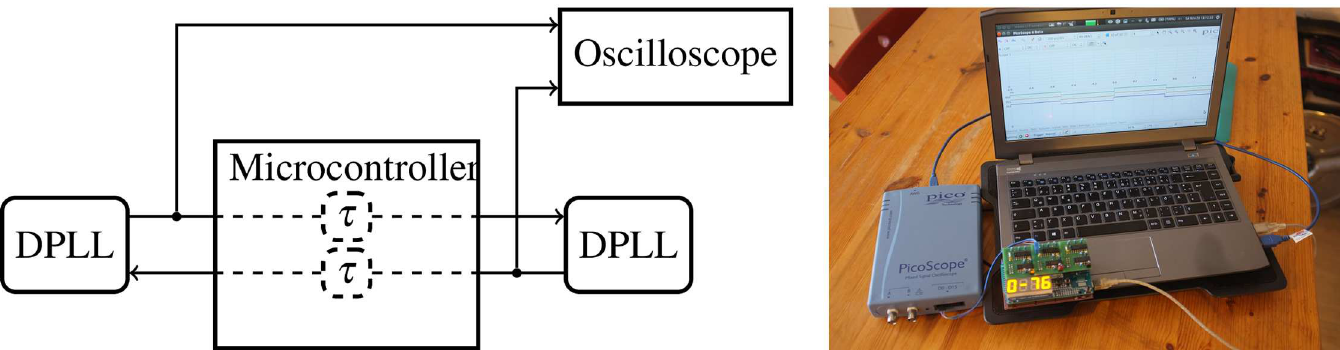
Fig 9. Experimental setup, sketch and photograph. Two DPLLs coupledthrough a microcontroller, which artificiallyintroducesa transmission delay. An oscilloscopesamplesthe periodicsignalsof the DPLLs. © 2015 IEEE. Reprinted,with permission, from IEEE Proceedings: Synchronizationof mutually coupleddigitalPLLs in massive MIMO systems